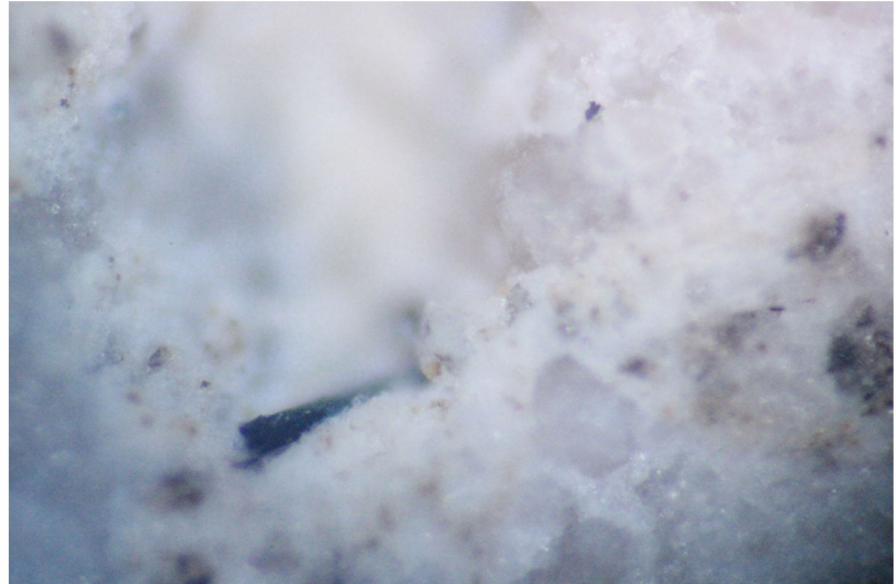
Figure 11. Specimen SB-S40 after exposure to 400 ◦ C under a polarization microscope (BK-POLR, magnification 100 × ).